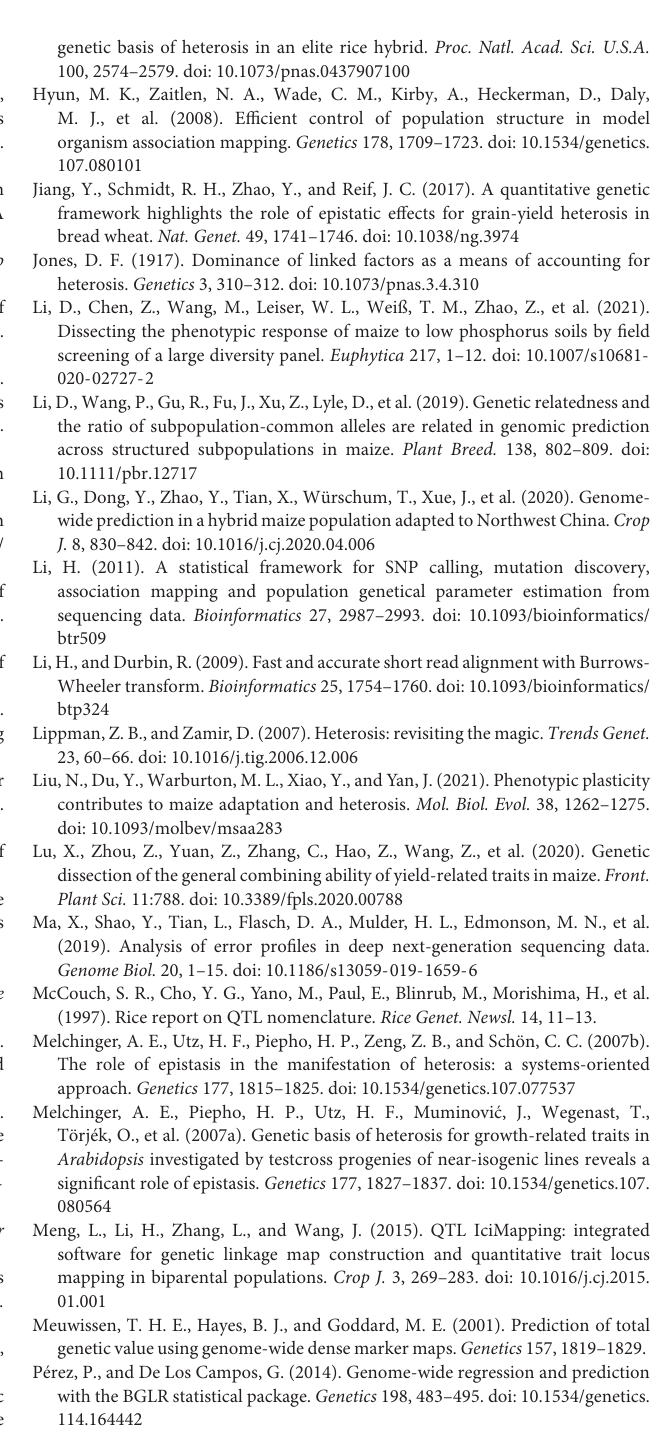
Supplementary Table 6 | Variance components and proportion of the phenotypic variance contributed by each variance component in the pooled Chang7-2 × RIL (TC)-Mo17 × RIL (TM) population. Supplementary Table 7 | Variance components and proportion of the phenotypic variance contributed by each variance component for midparent heterosis.